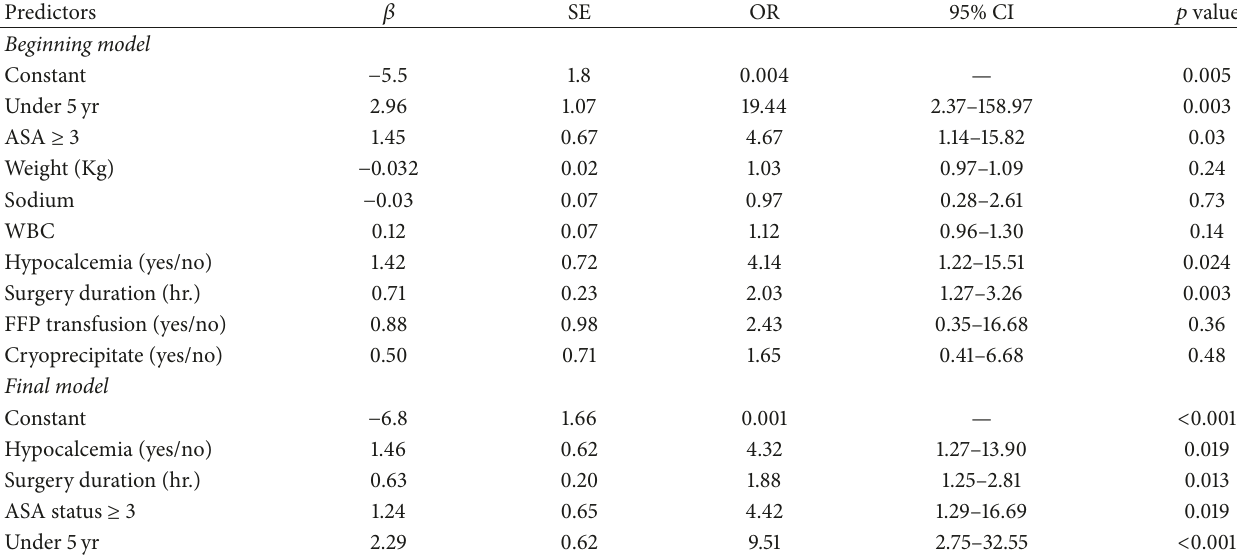
Table 3: Multivariable logistic regression model and parameters for factors associated with PPMV ( 𝑁 = 128